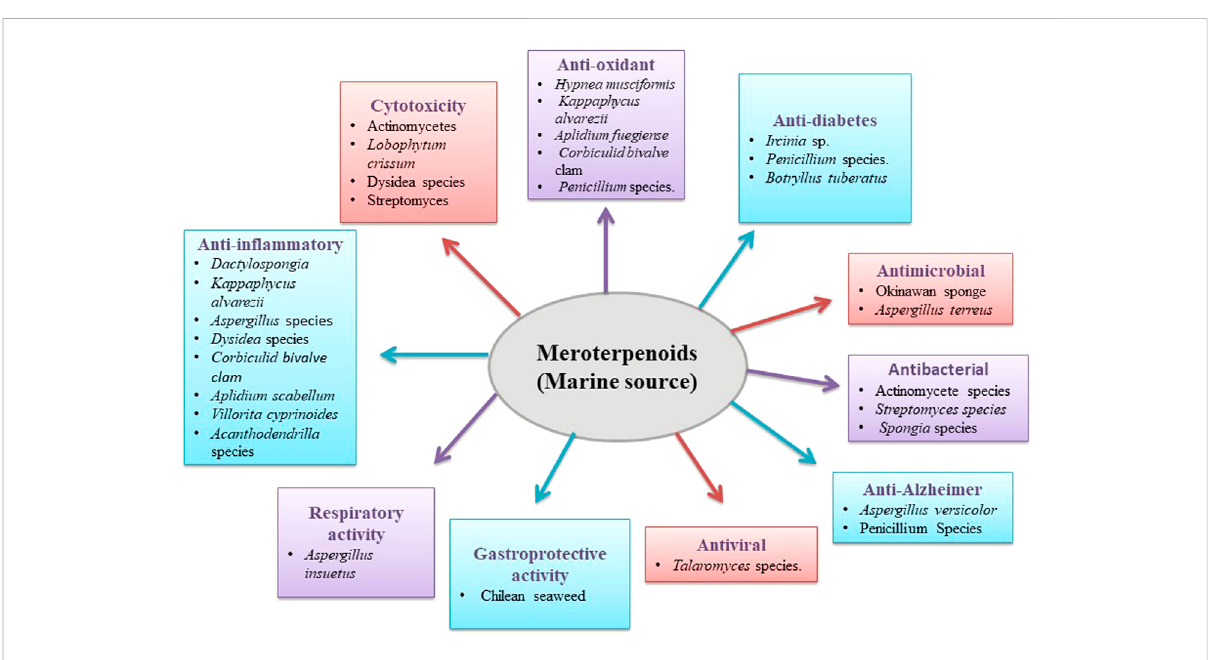
FIGURE 2 Biological activity of marine